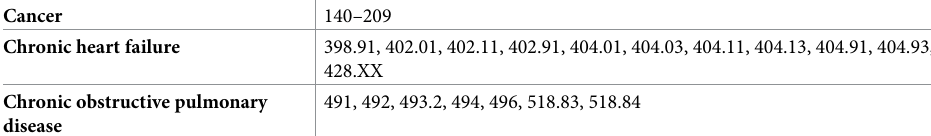
Table 1. Cancer and Cardiopulmonary failure inpatients diagnosis codes (ICD-9-CM) included in the